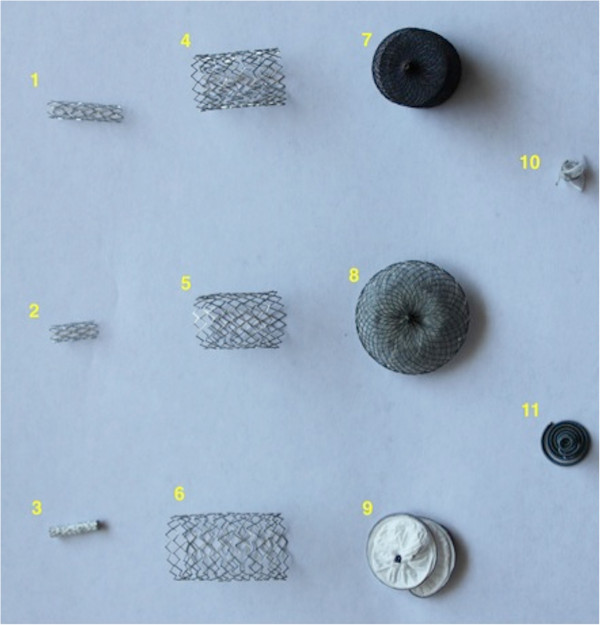
Photographic representation of devices.